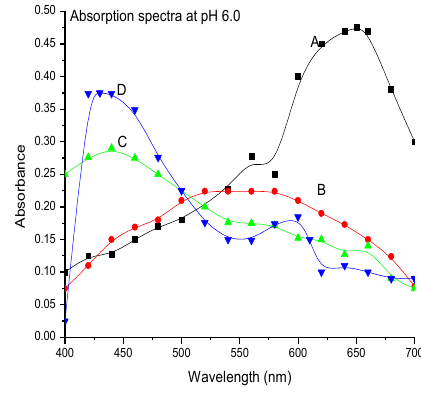
Figure 6. Absorption spectra of Y at pH 6.0, A- ECAB-CDMEAB-Y-(Ternary complex). B- ECAB-Y at(pH 6.0)-(Binary complex), C -ECAB-CDMEAB-(Modified reagent), D -ECAB-(Reagent) .